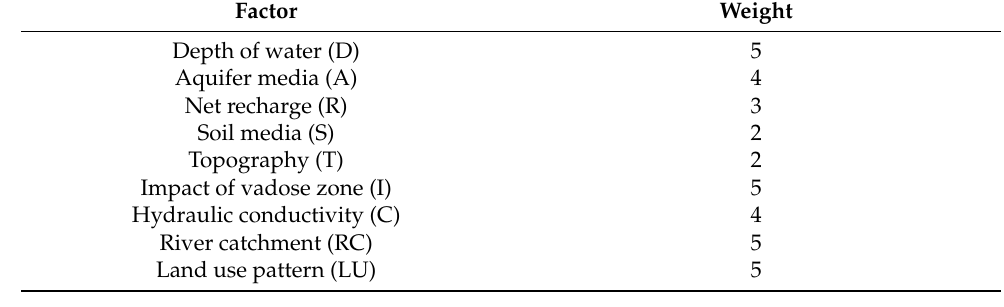
Table 2. The specific weight of the factors in the Mod-DRASTIC model [32,33,37].